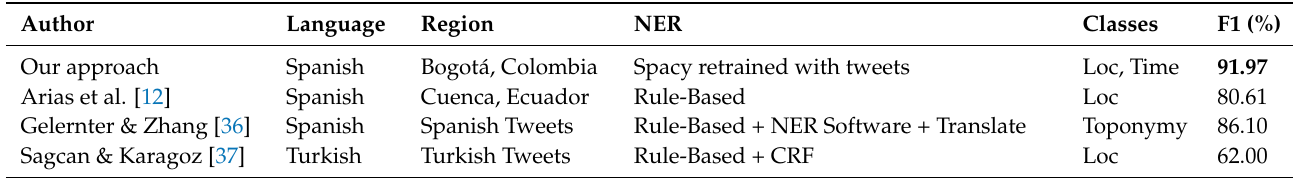
Table 12. Comparison between related studies and the Named Entity Recognition (NER) model in terms of language, region and F1 score.